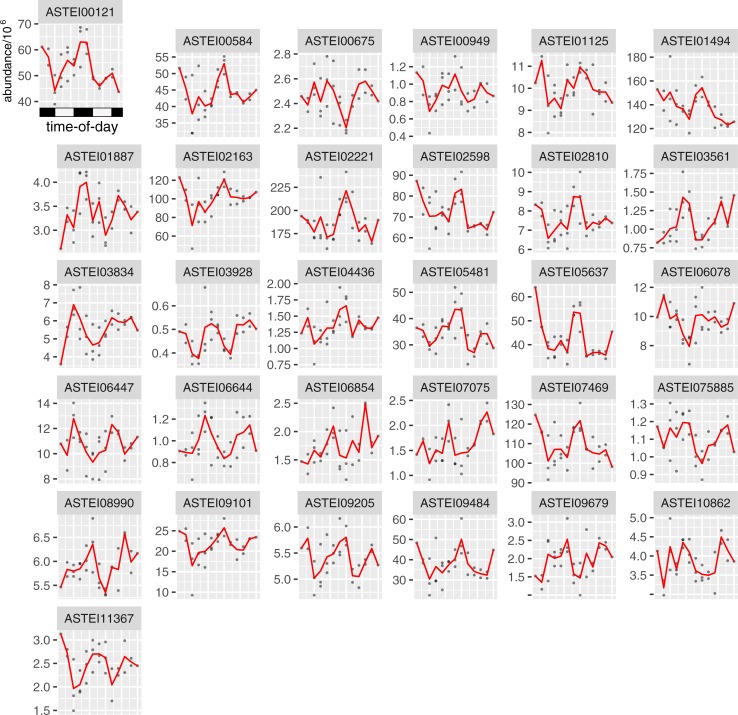
Proteins identified as rhythmic by JTK_CYCLE (p < 0.1, period length = 24hr).Each sub panel provides the protein abundance of one protein from three replicate experimental collections of mosquitoes. The horizontal white/black bar represents the light/dark (i.e. day/night) conditions under which the mosquitoes were collected. See Table 1 for gene name/functions.